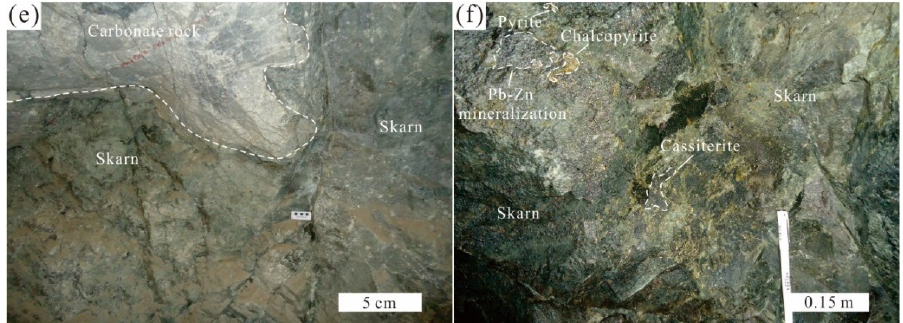
Figure 4. Field occurrences of ore-related skarns. The Huangshaping deposit: ( a ) fluorite and W–Mo–Sn mineralization developed in massive skarn; ( b ) W–Mo–Sn mineralization located at the contact zone between limestone and granite. The Shizhuyuan deposit: ( c ) greisen stockwork interweave within massive skarn; ( d ) fluoritization, Bi mineralization and quartz veins in massive skarn. The Xianghualing deposit: ( e ) contacting relationship between carbonate rock and skarn; ( f ) massive skarn mineralized by galena, sphalerite, pyrite, chalcopyrite and cassiterite.